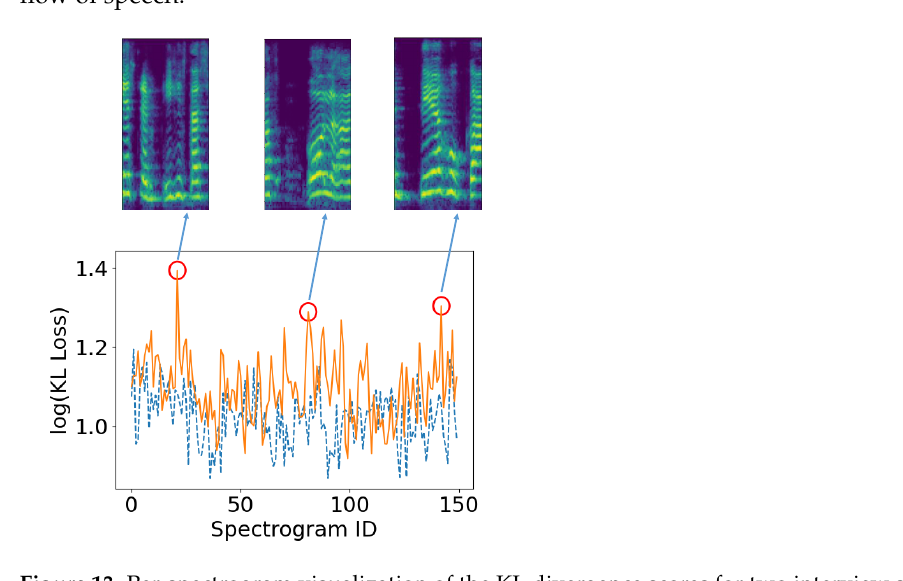
Figure 13. Per-spectrogram visualization of the KL divergence scores for two interview sessions of the same patient, one corresponding to stable (dashed blue) and one to relapsing (orange)